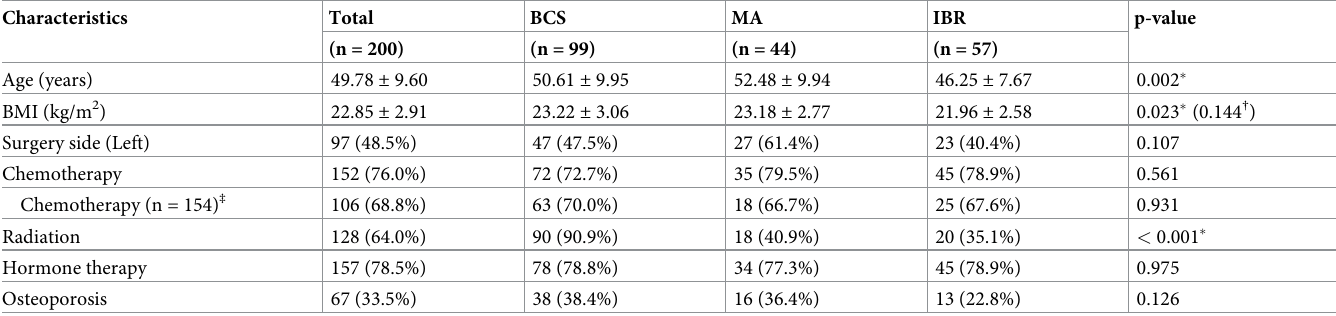
Table 1. Demographic and clinical characteristics.